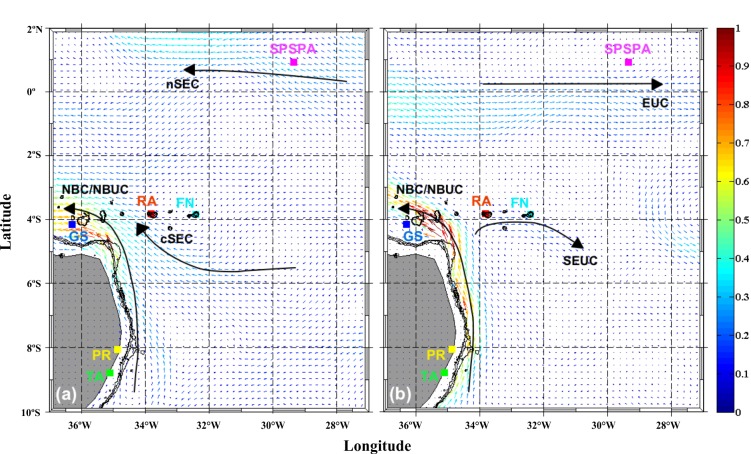
Horizontal distribution of current velocity from Mercator model results along 0–50 m (A) and 150 m (B). Chaetognaths sampling locations are indicated by colored squares—green: Tamandaré (TA); yellow: Port of Recife (PR); light blue: Guará seamount (GS); gray: Rocas Atoll (RA); dark blue: Fernando de Noronha Archipelago (FN); pink: Saint Peter and Saint Paul’s Archipelago (SPSPA). Main currents that surround in the areas: cSEC = central South Equatorial Current; nSEC north South Equatorial Current; NBC/NBUC = North Brazil Current/North Brazil Undercurrent system; EUC = Equatorial Undercurrent; SEUC = South Equatorial Undercurrent. The black lines represent the isobaths 50 m, 500 m and 1000 m.